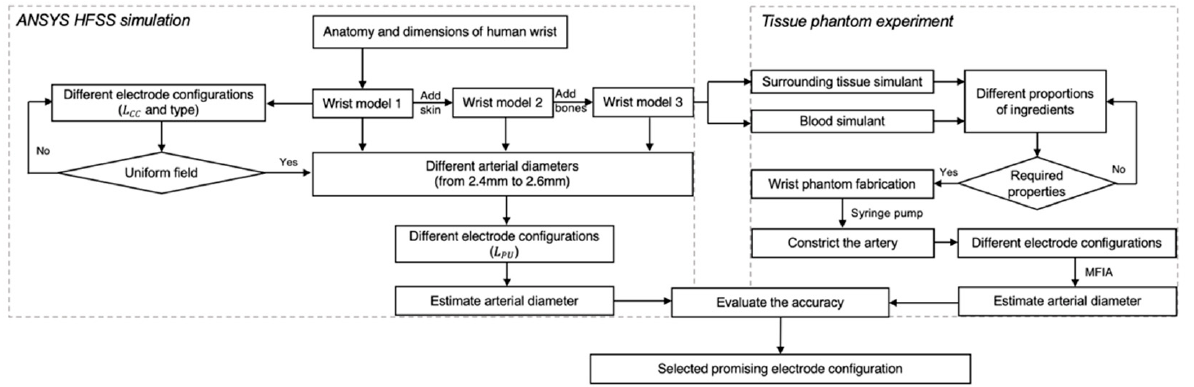
Figure 2. The flowchart of the overall process in this paper, including ANSYS HFSS simulation and tissue ‐ phantom experiments.